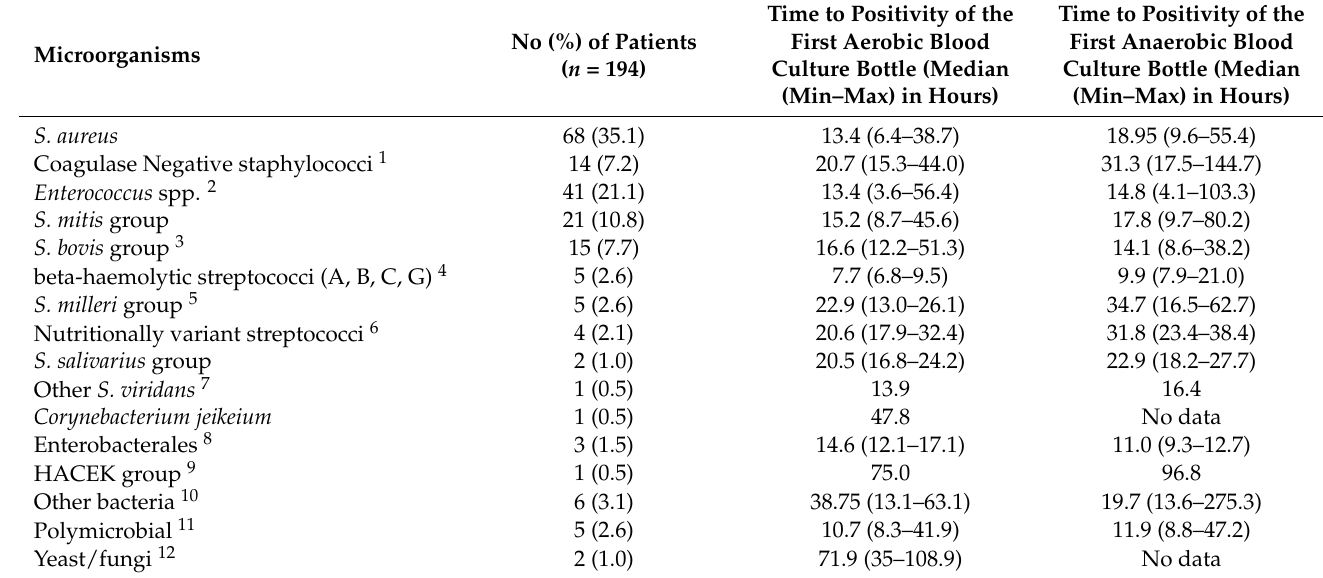
Table 1. Distribution of causative microorganisms of patients with infective endocarditis and blood culture time to positivity.